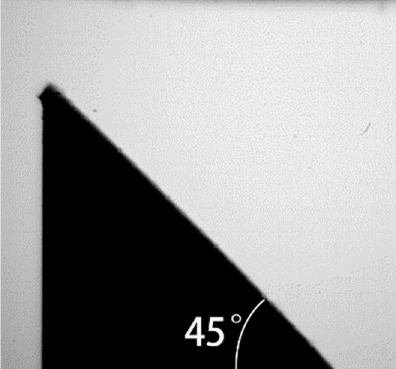
Figure 2. Impact platform with inclination angle of 45°. Table 1. Specific technical indexes of high-speed digital camera.